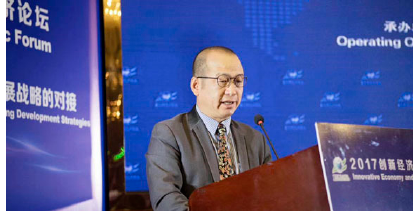
Figure 3. Dr. Xiaodan Mei, Executive Chair, President BIT Congress Inc.